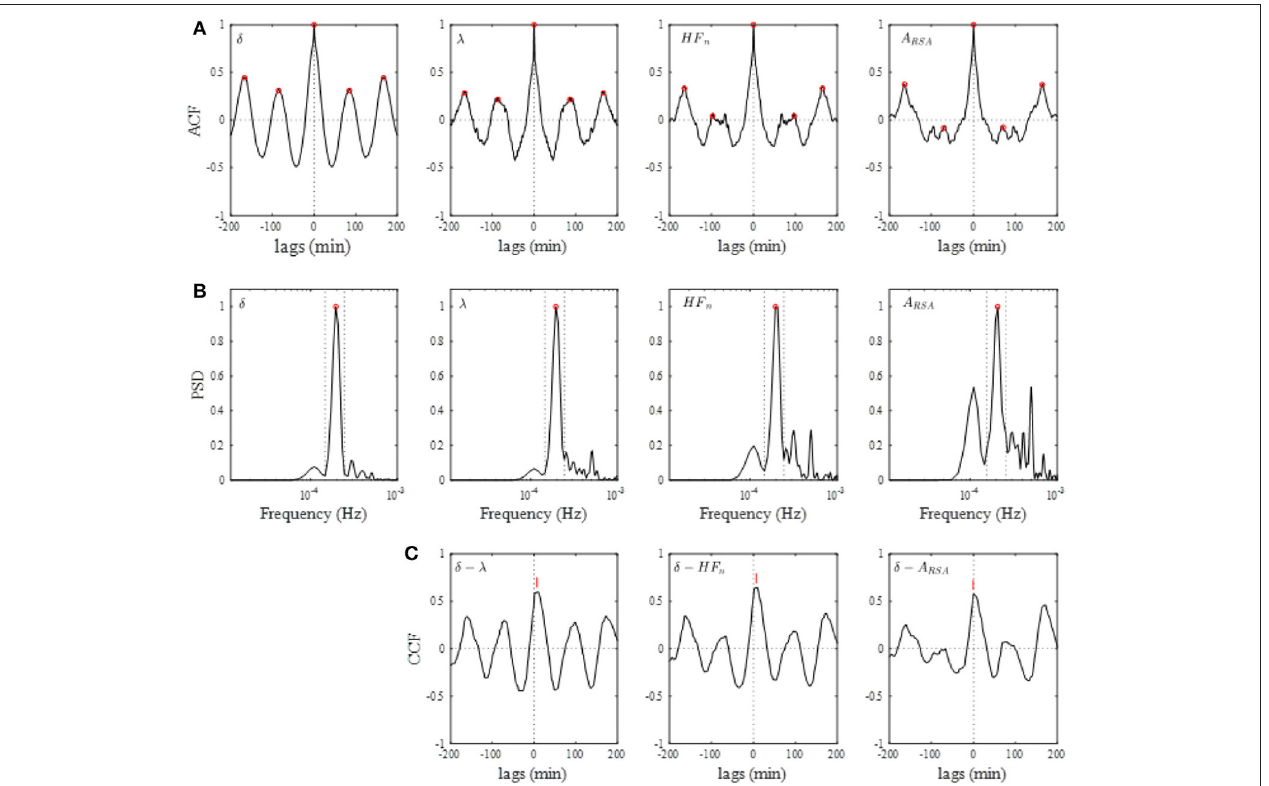
FIGURE 4 | (A) Auto-correlation functions (ACFs) of brain δ -wave, λ , normalized high-frequency component of HRV (HF n ), and amplitude of RSA (A RSA ), calculated from the entire night of sleep. Open red circles indicate peaks of ACF. (B) Normalized power spectral densities (PSDs) for the respective ACF. Open red circle, detected maximal peak; vertical dotted lines, 25% of the peak frequency. (C) Cross-correlation functions (CCFs) between δ -wave and λ , between δ -wave and HF n , ± and between δ -wave and A RSA . The lag time at which CCF attains its maximum is indicated by a red vertical bar in each